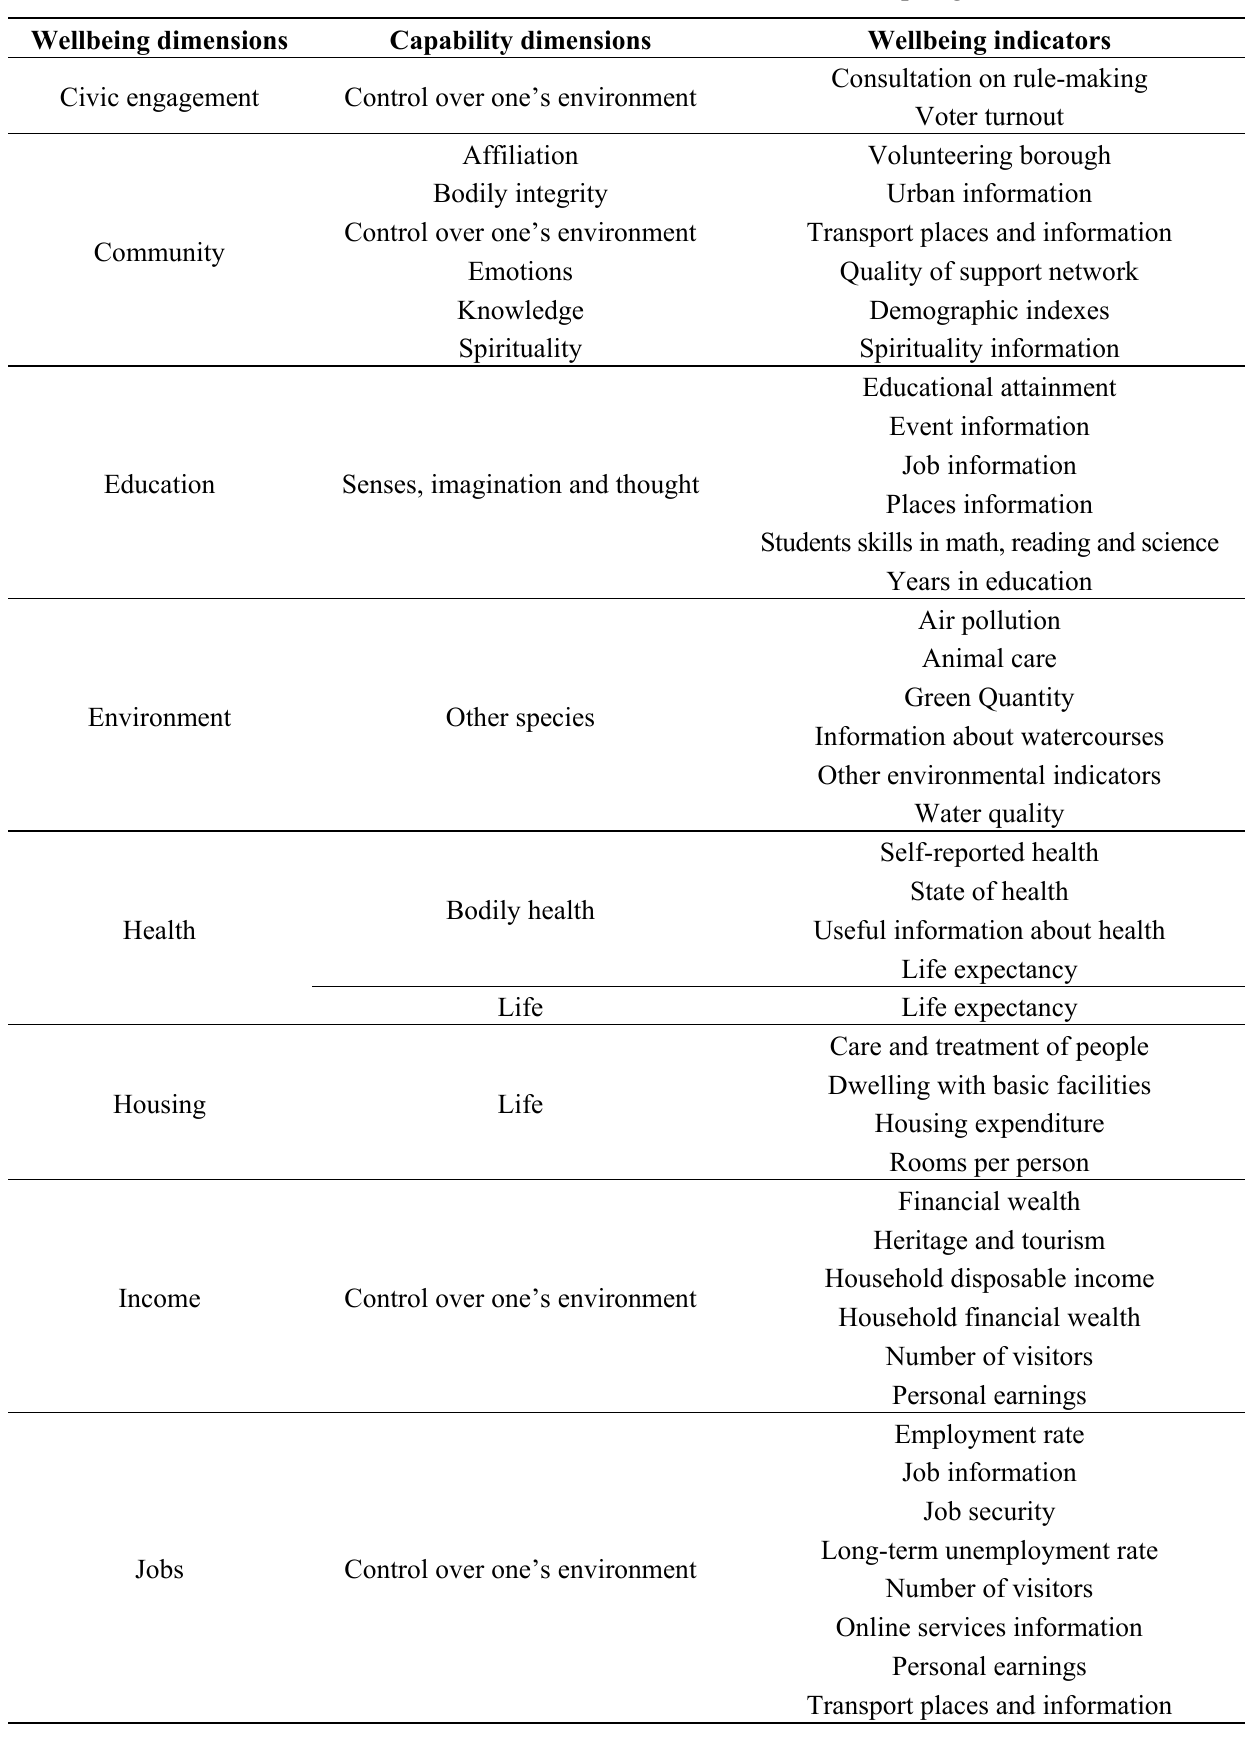
Table 1. Classification scheme for the assessment of the social value of open government data